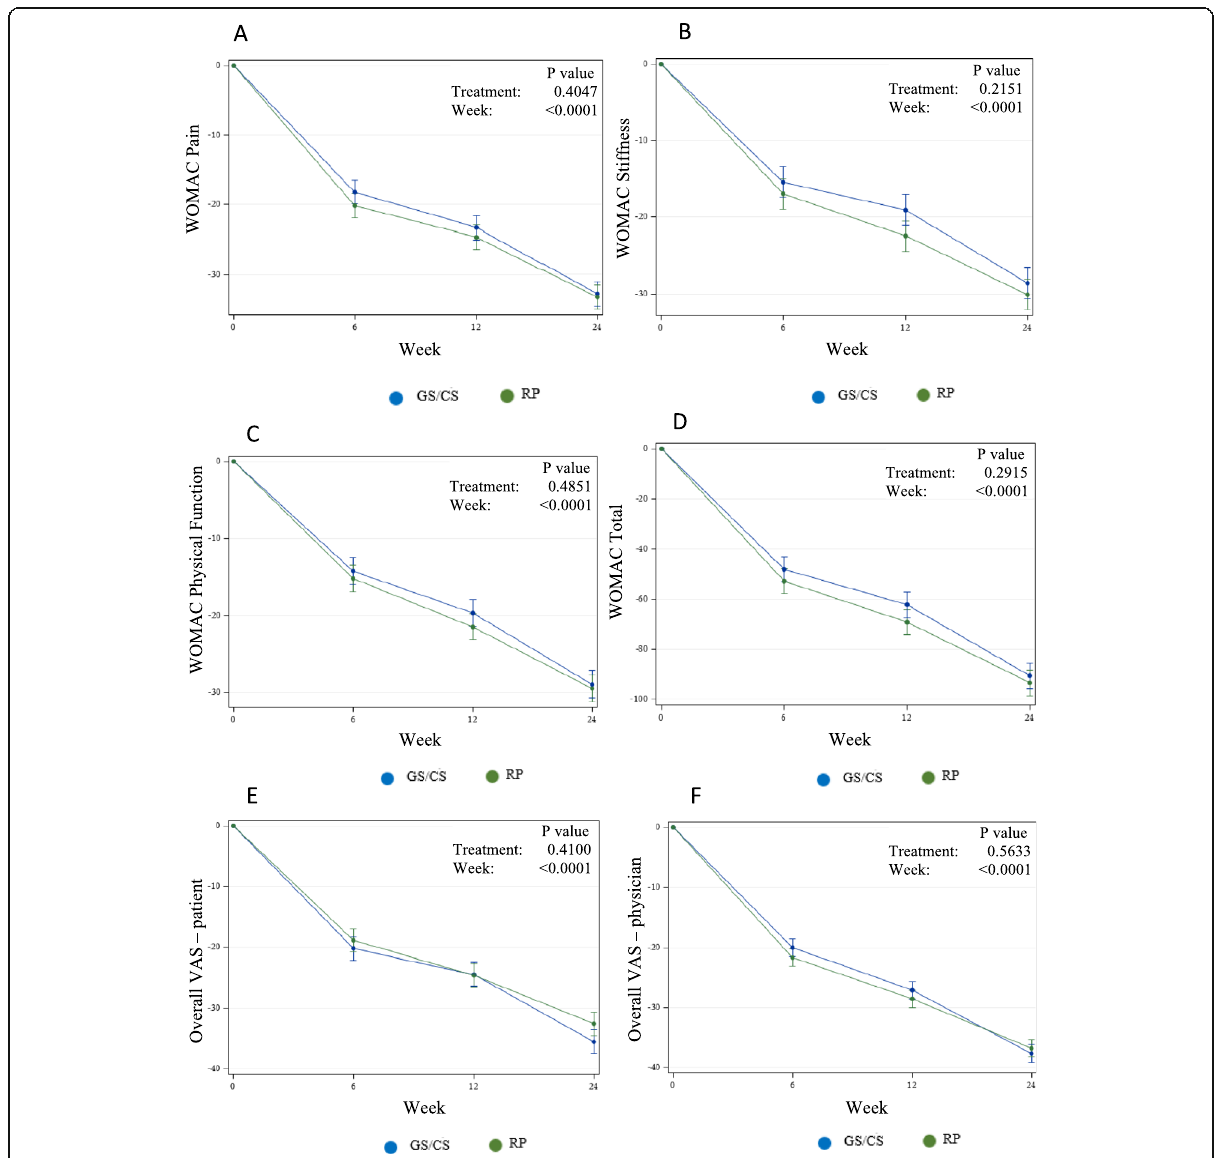
Fig. 2 WOMAC a “ pain ” subscale, b “ stiffness ” subscale, c “ physical function ” subscale and d total score; e VAS overall assessment of OA by the patient; f VAS overall assessment of OA by the physician. Adjusted estimates and two-sided CI (95%) of absolute ranges for each variable in PP population. P value indicates the differences between the treatment groups and between week 24 visit and baseline assessment. OA: osteoarthritis; RP: reference product; VAS: visual analogue scale; WOMAC: Western Ontario and McMaster Osteoarthritis